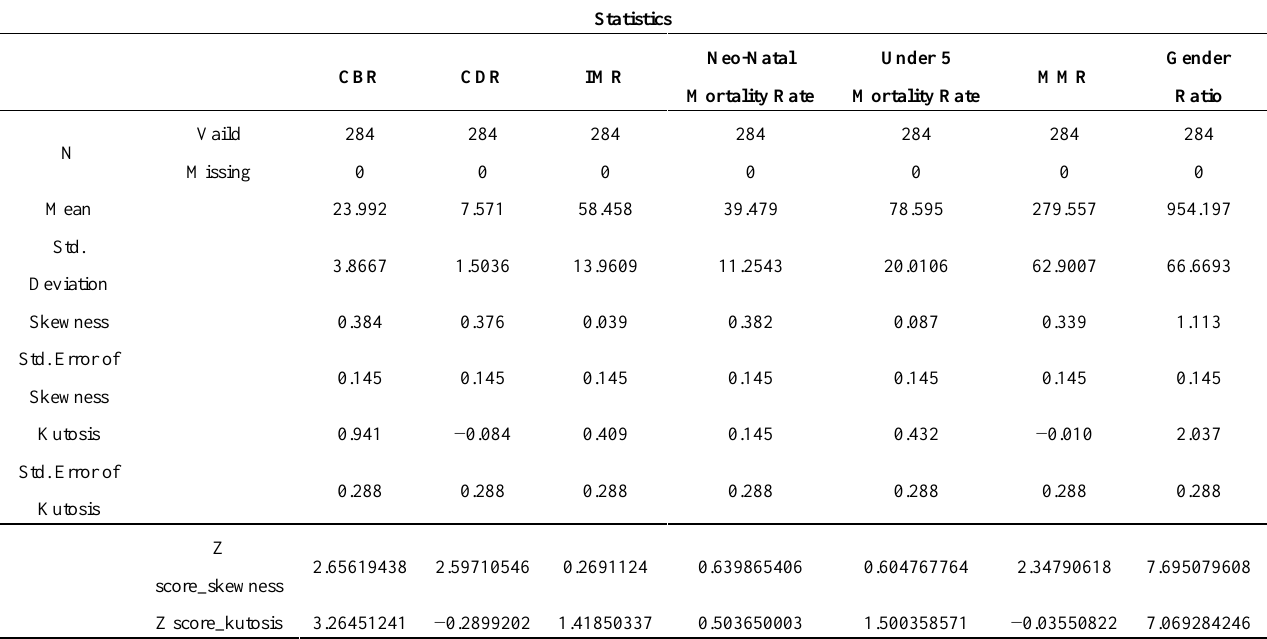
Table 1. Skewness and kurtosis of health metrics. CBR, crude birth rate; IMR, infant mortality rate; MMR, maternal mortality rate.